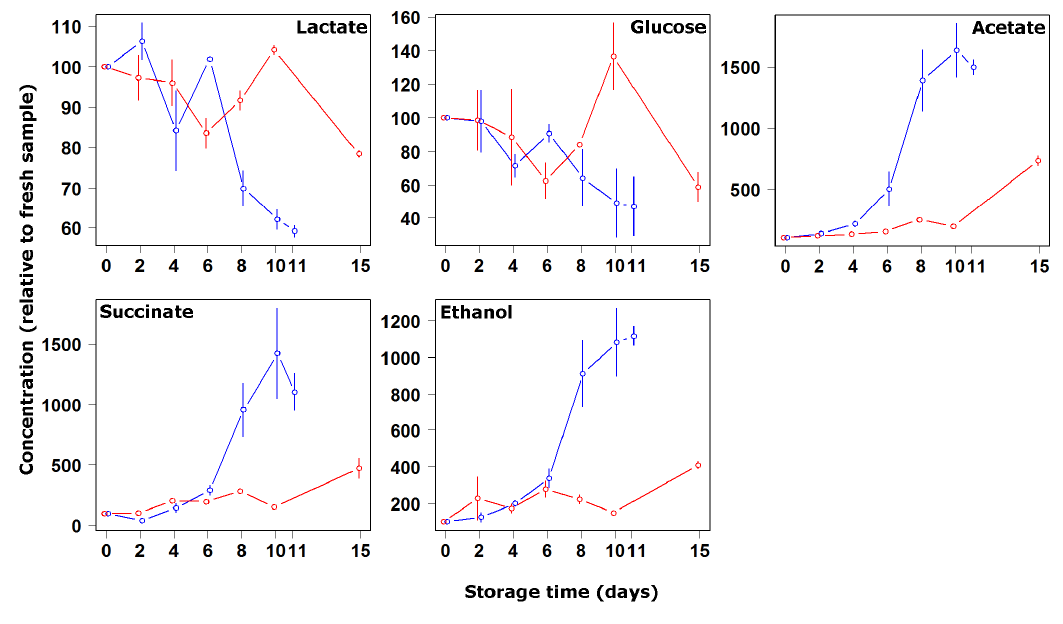
Figure 4. Concentration changes relative to fresh samples of lactate, glucose, acetate, succinate and ethanol during storage at 4 °C (blue symbols and lines) and on ice (red symbols and